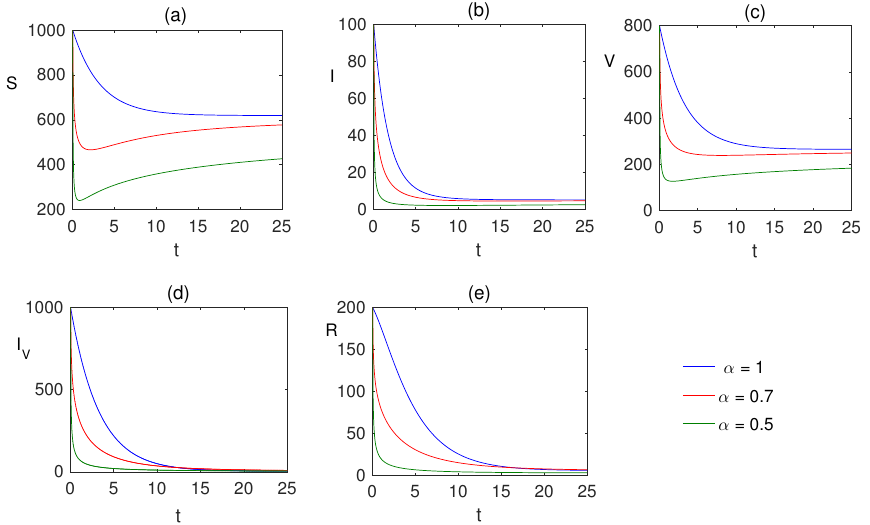
Figure 4. Numerical solution of ( a ) susceptible S ( t ) , ( b ) infected I ( t ) , ( c ) vaccinated population V ( t ) , ( d ) infected population after vaccination I V ( t ) and ( e ) recovered populations R ( t ) are plotted for showing the dynamics of the fractional ordered model (7) when α = 1, 0.7, 0.5 and the fear factors are α 1 = 0.29 and α 2 =